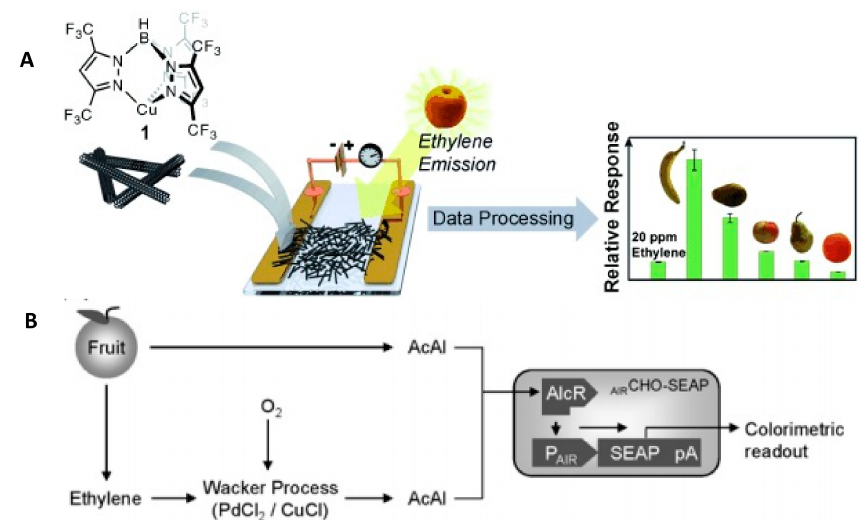
Figure 6. ( A ) Schematic representation of an ethylene chemoresistive sensor. Mixture of a Cu (I) complex and single-walled carbon nanotubes (SWNTs) were drop-cast between gold electrodes. When ethylene binds to the mixture, resistance changes. (Reproduced with permission from Reference [28]). ( B ) Dual-channel catalytic-biosensor. Acetaldehyde (AcAl) generated by fruit diffuses through the gas phase to biosensor cells ( AIR CHO-SEAP) genetically engineered to express the Aspergillus nidulans -derived transactivator AlcR that, in the presence of acetaldehyde, activates its cognate promoter PAIR, driving expression of the reporter gene SEAP (AIRCHO-SEAP cells). Ethylene is oxidized to acetaldehyde on PdCl 2 with Cu + based on the Wacker process. The generated acetaldehyde is captured by AIR CHO-SEAP and converted into SEAP expression, measured as a colorimetric signal (reproduced with permission from Reference [78]).